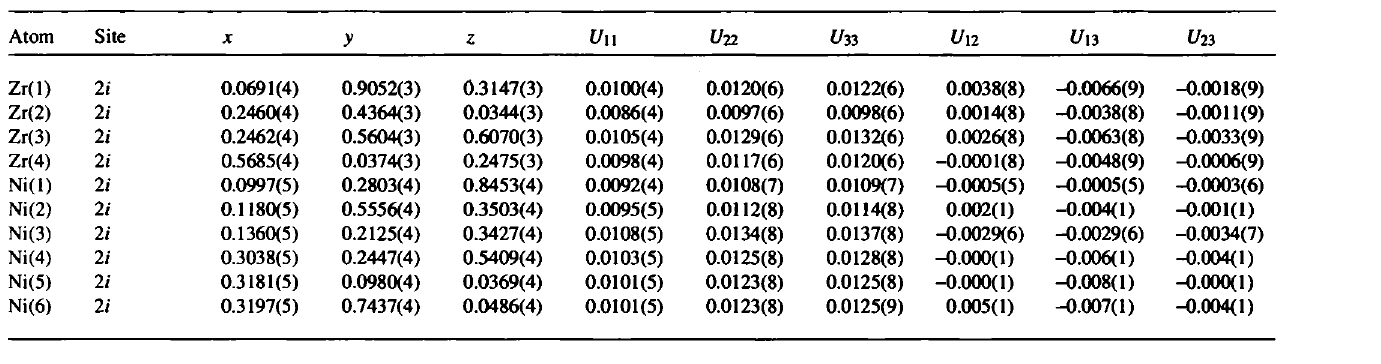
Table 2. Final atomic coordinates and displacement parameters (in h?)